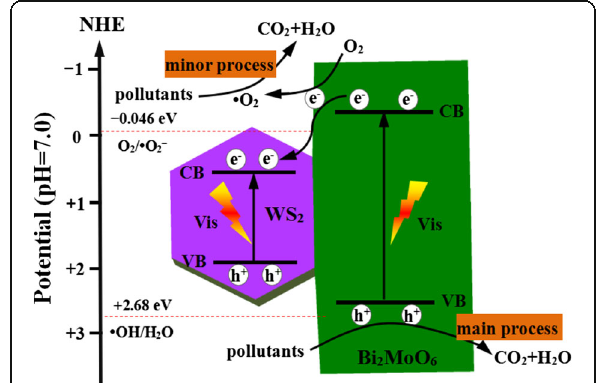
Fig. 10 The proposed photocatalytic mechanism scheme of WS 2 /Bi 2 MoO 6 composite under visible light (>420